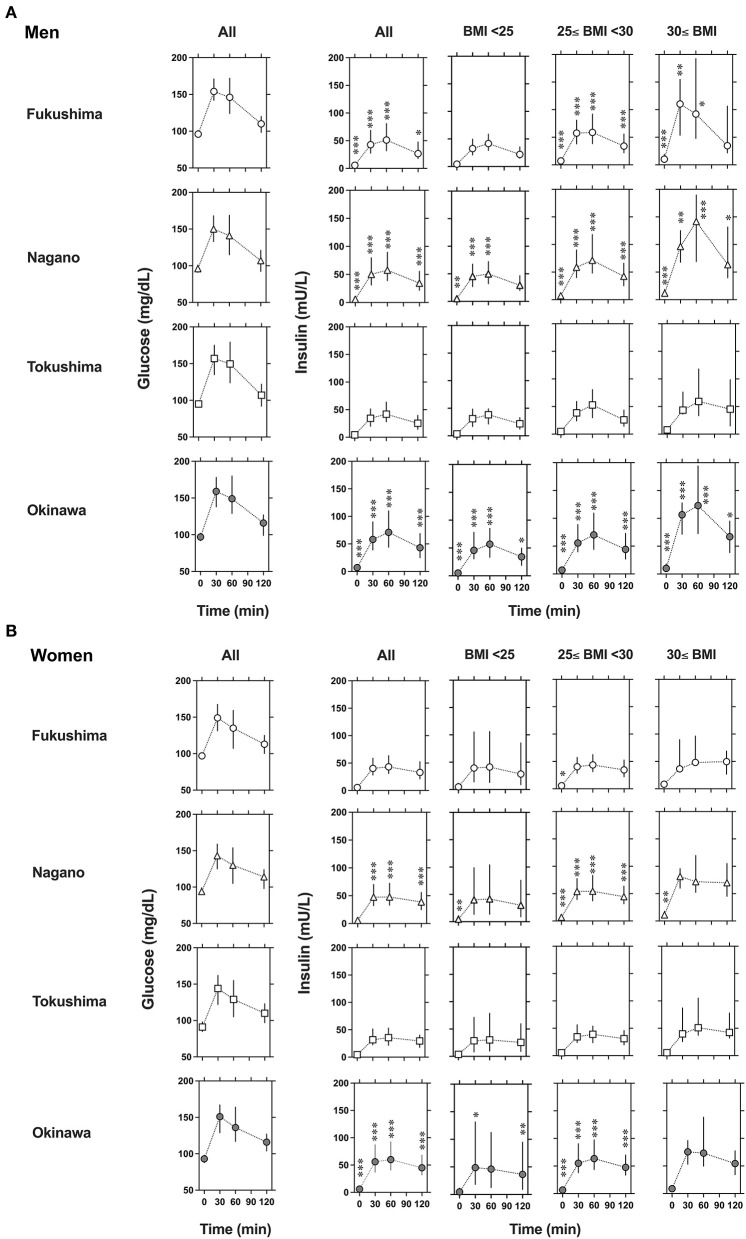
Changes in glucose and insulin levels in men (A) and women (B) during the 75-g oral glucose tolerance test. Glucose levels are shown in left panels and insulin levels are shown in right panels for all or stratified categories across three body mass index (BMI), BMI <25, 25 ≤ BMI <30, and BMI ≥ 30. The participants were randomly selected from the National Health Insurance database in Fukushima (°), Nagano (Δ), Tokushima (□) and Okinawa (•), Japan. Data are presented as median (25–75th percentile). To compare deference between the regions at each point, P-values were obtained by Kruskal–Wallis test, followed by Dunn's multiple comparisons test using Tokushima as a control. *P < 0.1, **P < 0.05, and ***P < 0.01 vs. Tokushima.